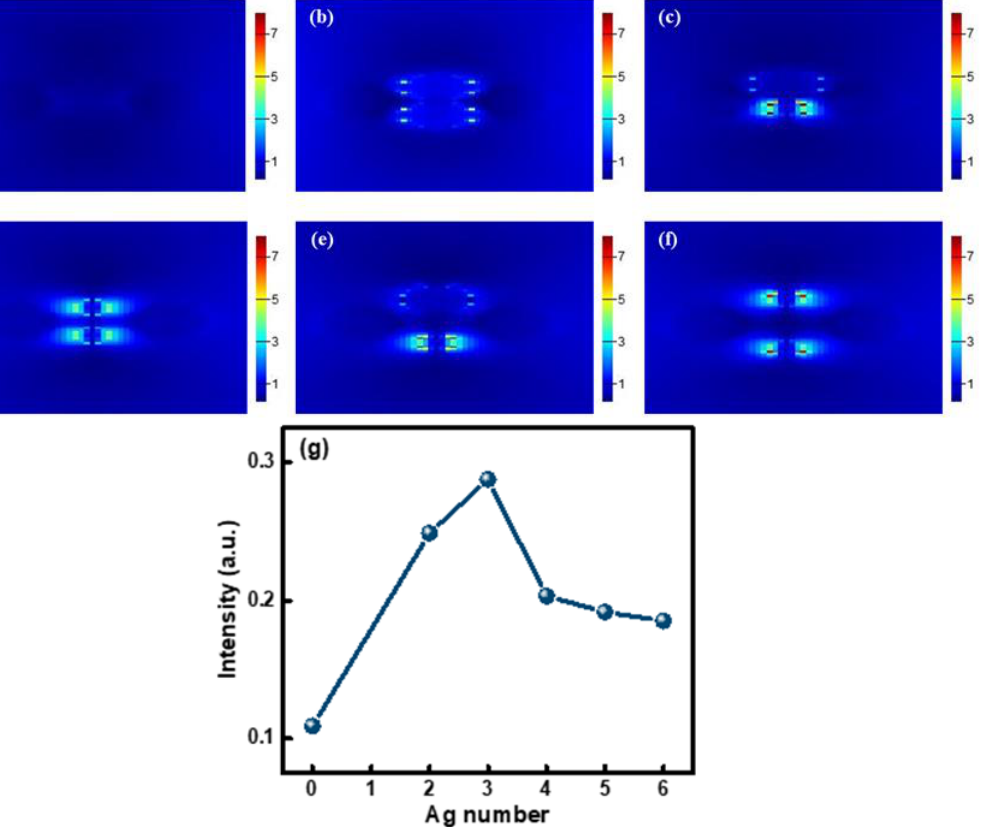
Figure 9. ( a – f ) Electric field intensity distribution of different numbers of Ag NPs in CsPbBr 3 QD- doped glasses under excitation light calculated by using the FDTD method and ( g ) emitted light intensity of CsPbBr 3 QD-doped glasses model containing different numbers of Ag NPs.